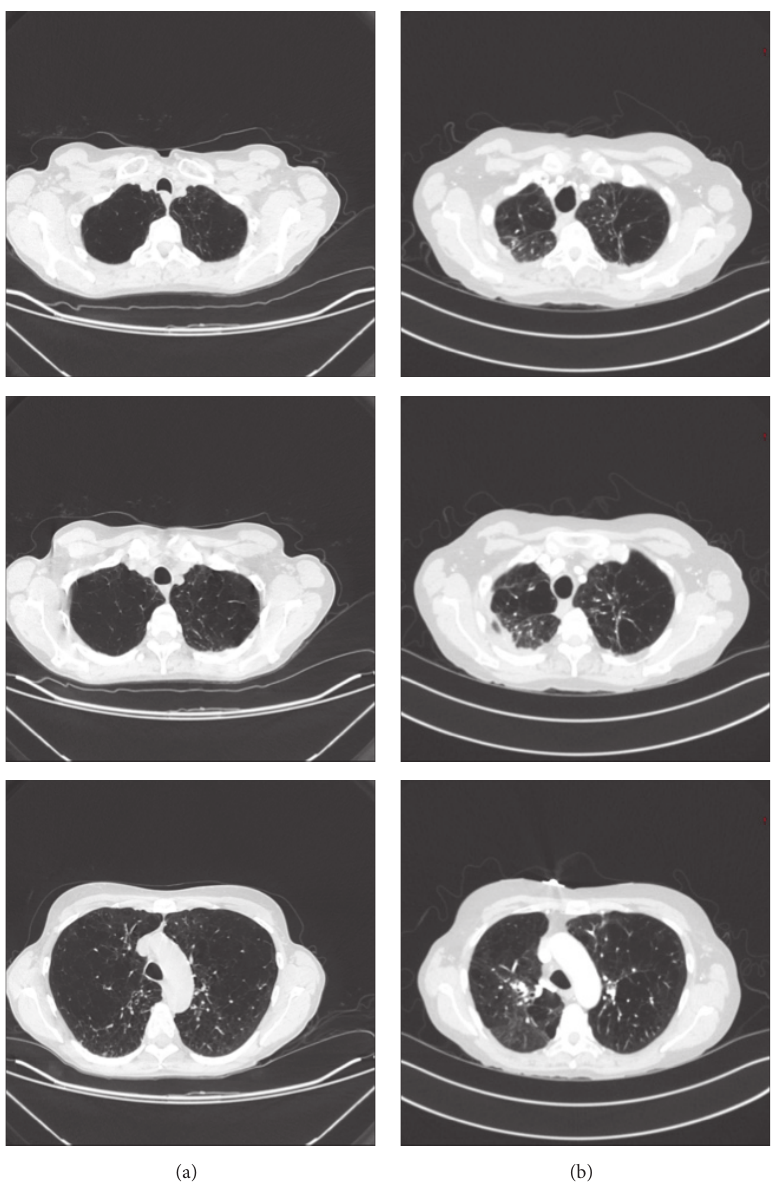
Figure 2: Baseline CT scan (a) which shows diffuse emphysema and a follow-up CT (b) which shows apical scarring predominantly on the right and right apical pleural